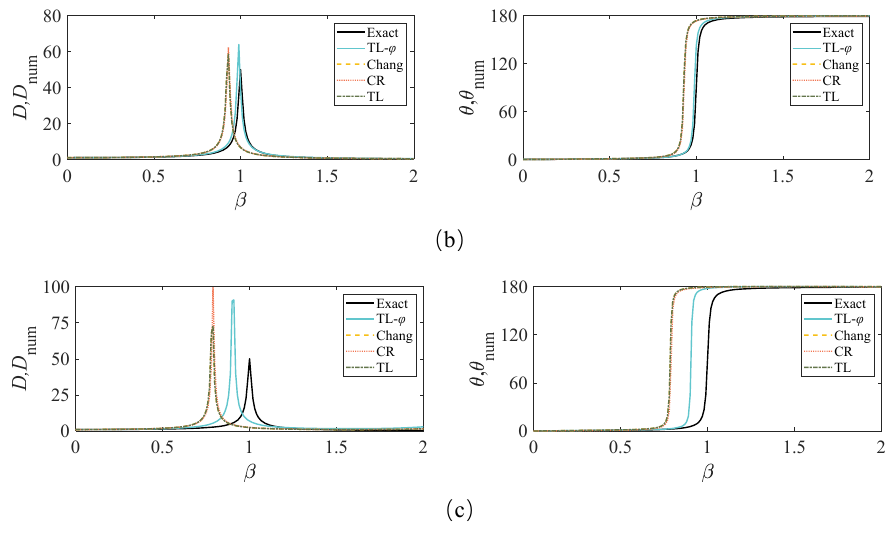
Figure 1. Numerical DMF D num and phase θ num for TL- ϕ algorithms compared with the exact solution of dynamic magnification factor D and phase θ . ( a ) Ω = 0.2. ( b ) Ω = 1.0. ( c ) Ω =